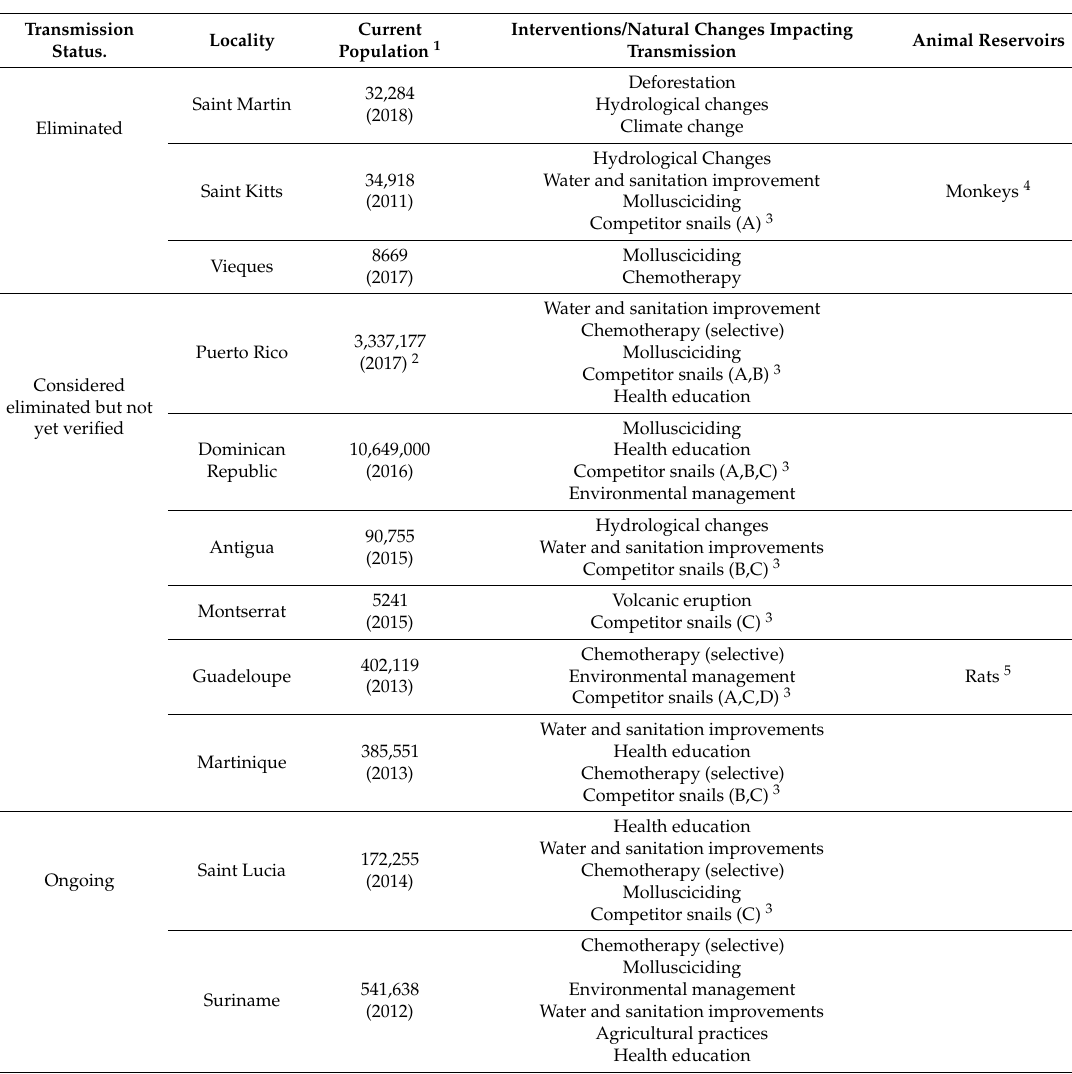
Table 1. Transmission status of Caribbean localities with a history of schistosomiasis endemicity noting interventions implemented and natural changes affecting transmission as well as presence of animal